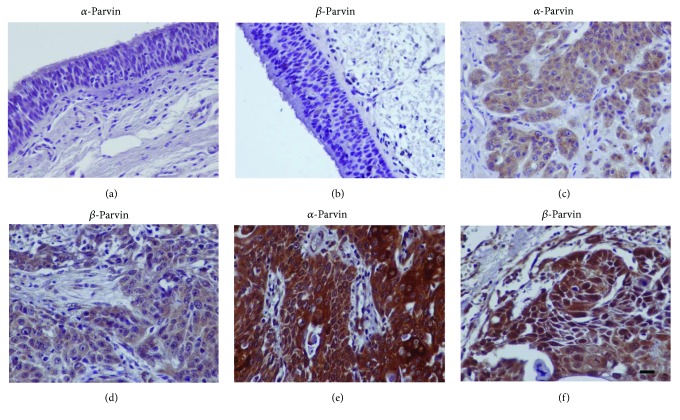
Expression of parvins by immunohistochemistry in human laryngeal carcinoma. (a, b) Negative expression in the adjacent nonneoplastic epithelium. (c, d) Representative cases of laryngeal carcinomas with low expression of parvins. (e, f) Representative cases of laryngeal carcinomas with high expression of α-parvin (e, cytoplasmic) and β-parvin (f, cytoplasmic and nuclear). Bar corresponds to 50 μm (×400).